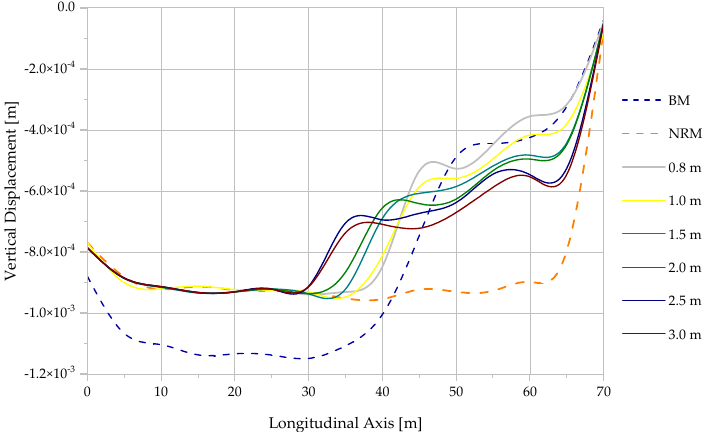
Figure 11. Vertical displacements when implementing the PA.